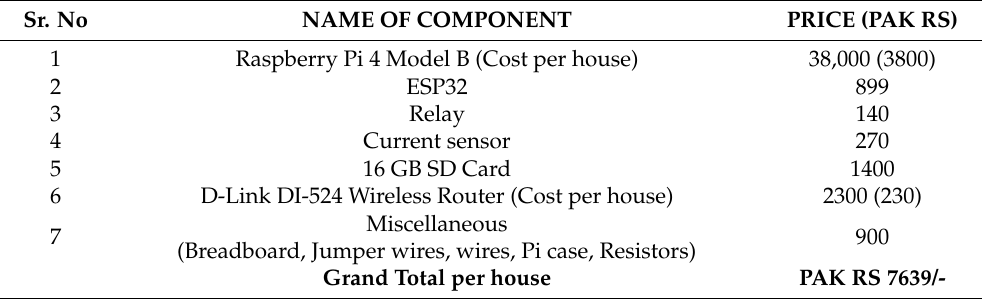
Table 1. An itemized bill of components.